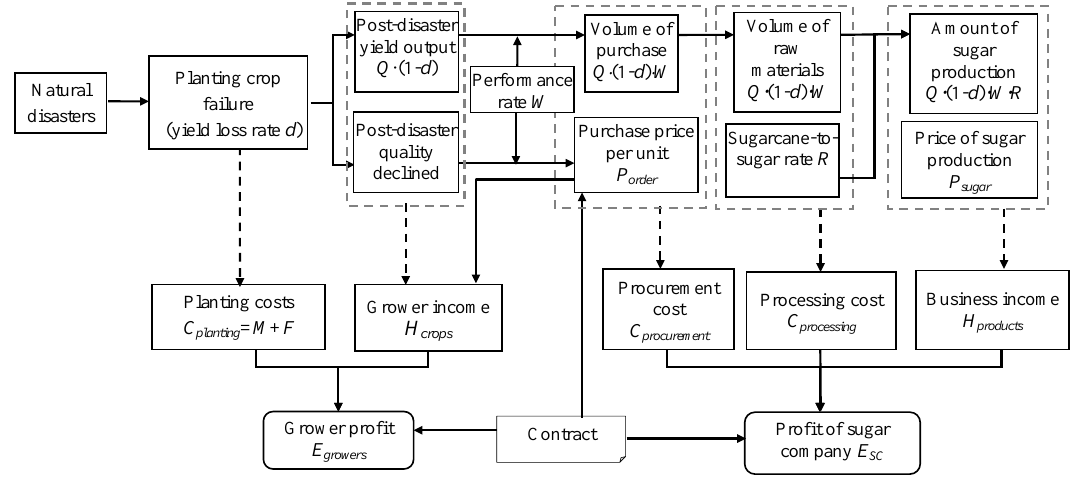
Figure 4. Transfer processes of disasters in the sugar industry.